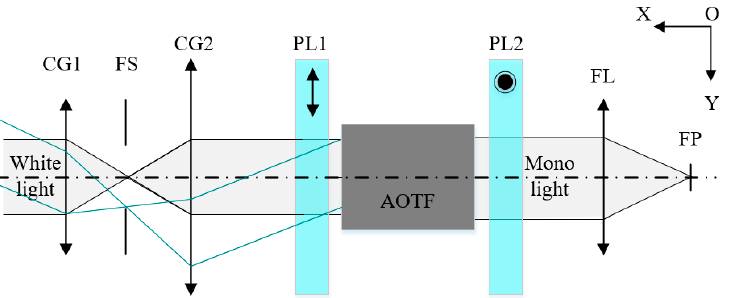
Figure 2. The simulation optical scheme of the system. CG1 and CG2: collimator group; FS: field stop; PL1 and PL2: polarizer; FL: focal lens; FP: focal plane; OY: the direction of acousto-optic diffraction and the column direction.